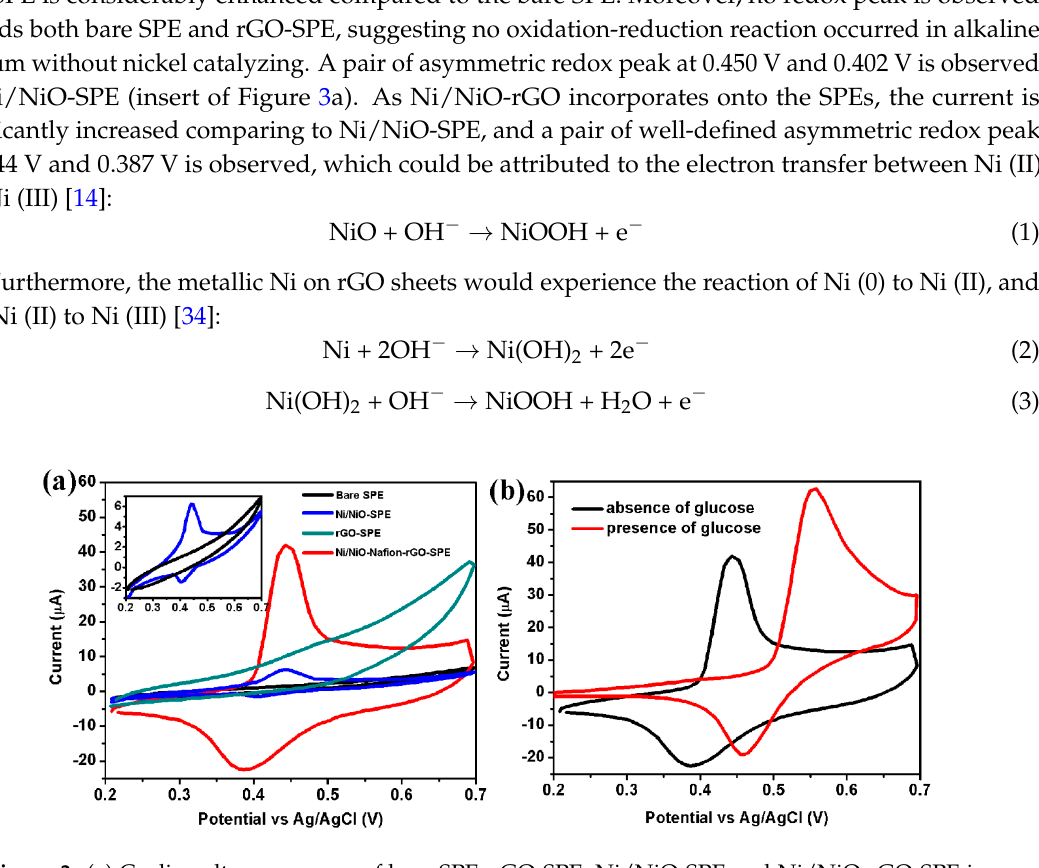
Figure 3. ( a ) Cyclic voltammograms of bare SPE, rGO-SPE, Ni/NiO-SPE and Ni/NiO-rGO-SPE in 0.1 M NaOH at scan rate of 50 mV/s (insert show the magnification of bare SPE and Ni/NiO-SPE); ( b ) Cyclic voltammograms of Ni/NiO-Nafion-rGO modified SPE in absence (black curve) and presence (red curve) of 3 mM glucose in 0.1 M NaOH.